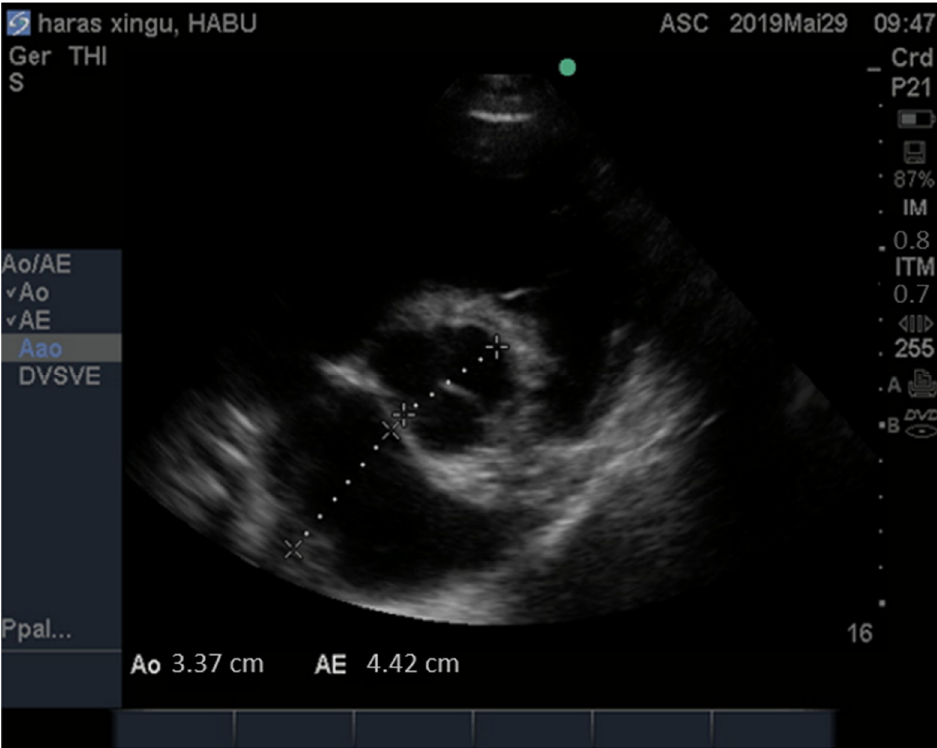
Figure 2. Image obtained by the two-dimensional echocardiogram of a donkey, male, 6 years old, right parasternal window, cross-section, aortic plane, left atrium/aorta ratio (LA/Ao).